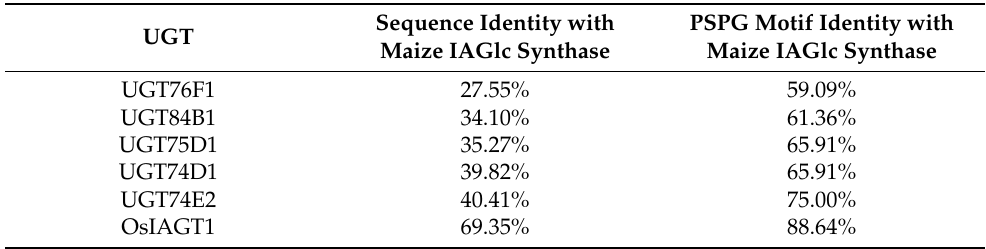
Table 4. Sequence identities of IAA glucosyltransferases. The sequence identities were calculated using Clustal